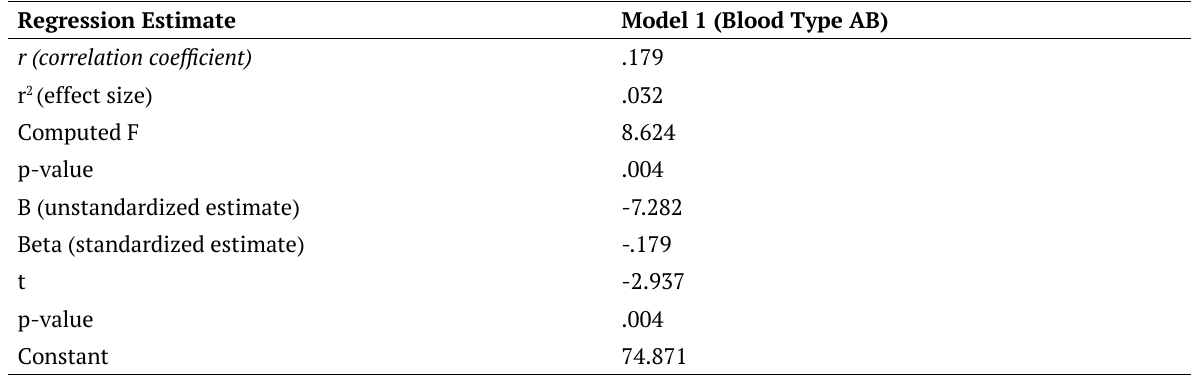
Table 8. Regression estimation procedures of the factors towards students’ strength Regression